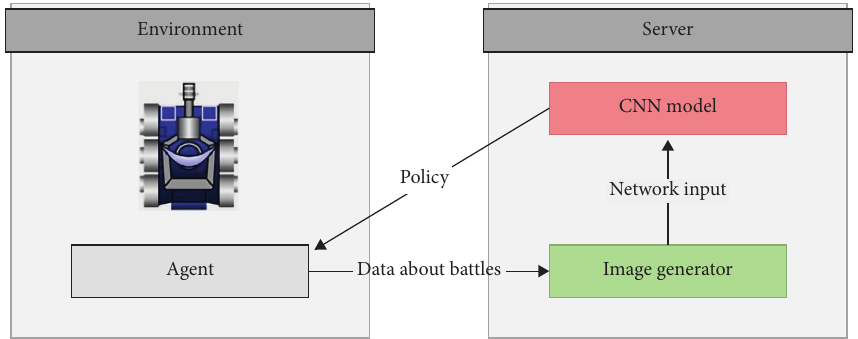
Figure 3: The flowchart diagram illustrating the relationship between agent and